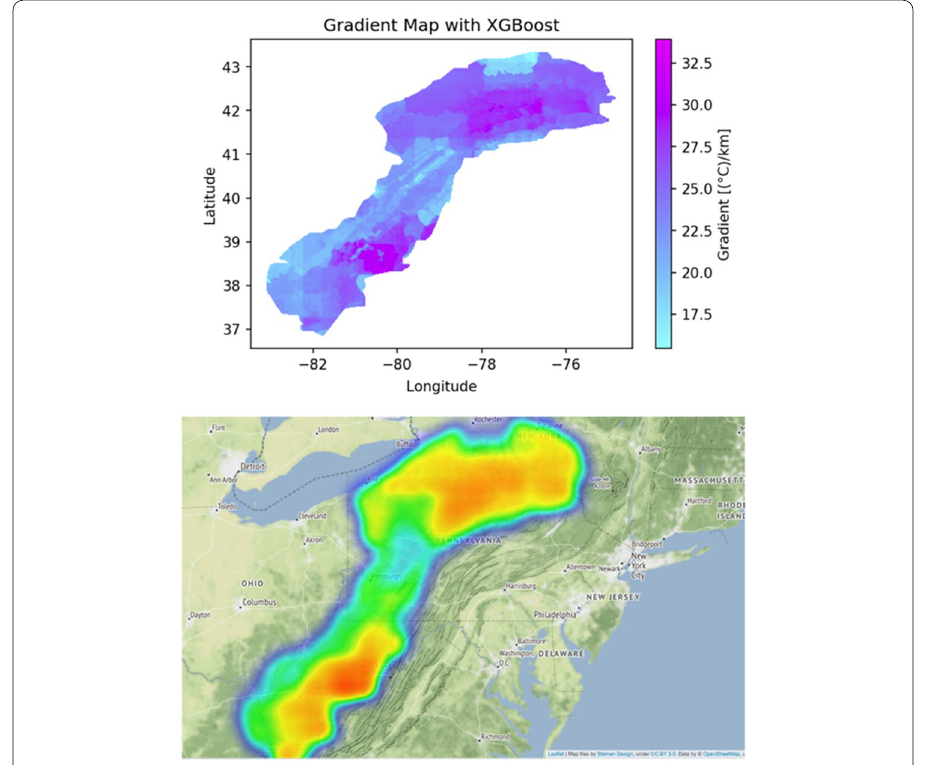
Fig. 12 Geothermal gradient map using XGBoost model. The gradient has the unit of ◦ C km